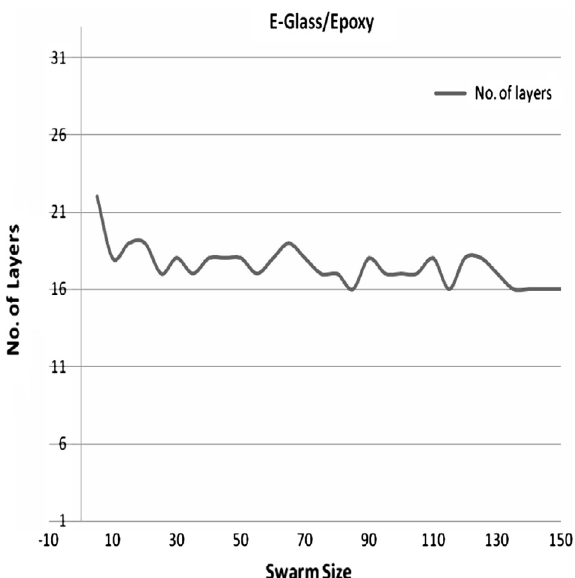
Figure 6. Variations of number of layers of E-glass/Epoxy drive shafts with respect to swarm